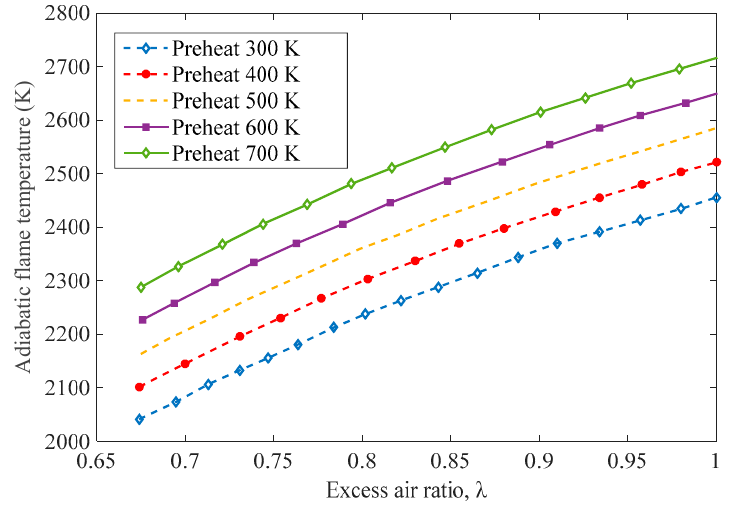
Figure 5. Adiabatic flame temperature under fuel rich conditions with different preheats.